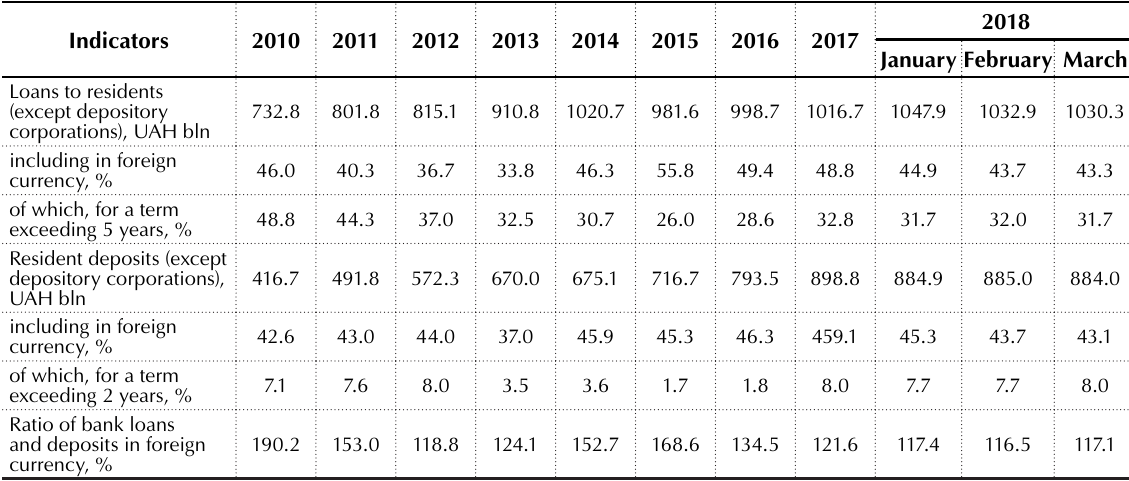
Table 1. Loans and deposits to residents, except for depository corporations, by currency